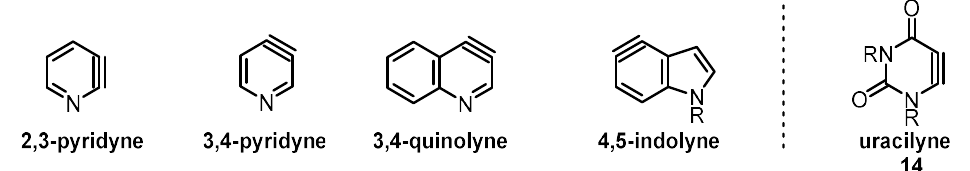
Figure 2. Reported heteroarynes and uracil-heteroaryne analog 14 .